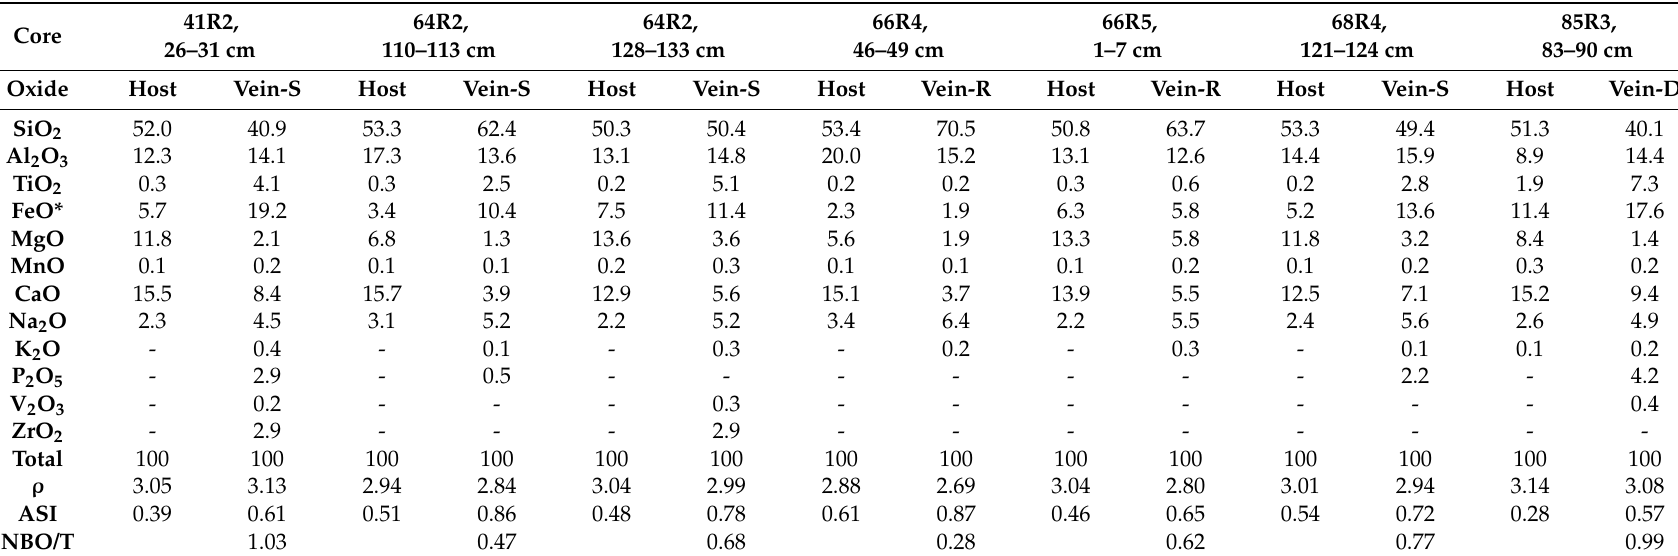
Table 4. Summary estimated dry bulk rock compositions (wt.%) of the host gabbros and felsic veins—Hole